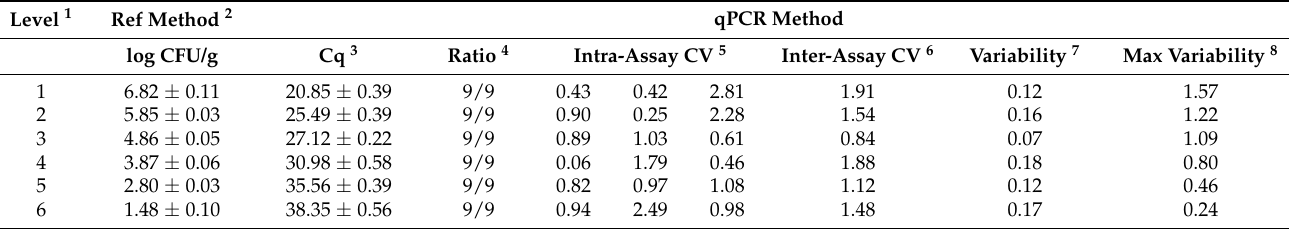
Table 3. PCR validation results of experimentally contaminated cured ham